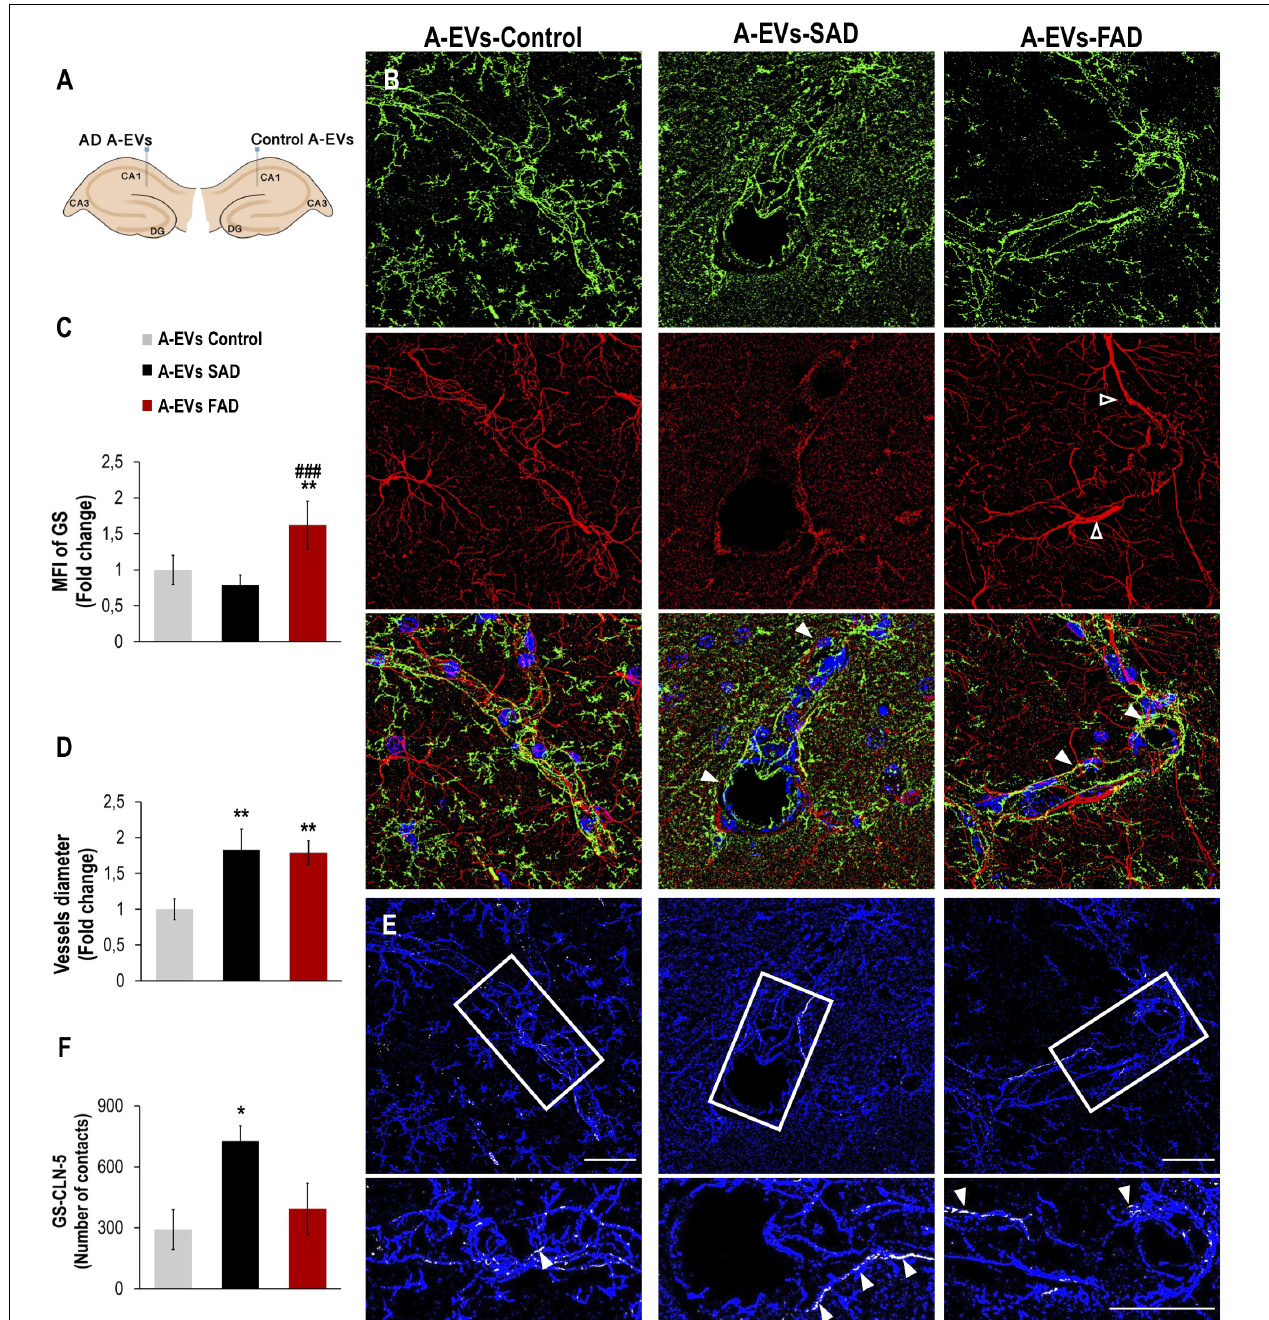
FIGURE 7 | Alzheimer’s disease EVs but not control EVs injection cause GS astrocyte alteration and higher vessel diameter in wild-type mouse brains. (A) A schema illustrating EVs from human A-EVs bilaterally injected to the hippocampus of C57BL6 mice at 10 months of age. (B) Representative of maximal Z-projection of Hoescht (blue), CLN-5 (green), GS (red) staining 48 h after intrahippocampal injection of CNT, FAD- and SAD A-EVs into aged C57BL6 mouse brain. Original magnification: × 60 (zoom 1.6). White arrowheads indicate regions where high vascular diameter, while empty arrowheads point to increased GS. (C) Quantification of the Z projected intensity of GS. ANOVA comparations of A-EVs FAD with ∗ A-EVs Control and # A-EVs SAD, levels of significance were set to * p < 0.05, ** p < 0.01, and ### p < 0.001. (D) Quantification of vessels diameter using of the CLN-5 Z projected images. ∗ Comparison with AEVs Control, levels of significance were set to ** p < 0.01. (E) Segmented images of GS endfeet (white) contacting CLN-5 vessel (blue). White arrowheads indicate regions where focal GS vascular coincides with CLN-5 staining. The insets are crop magnifications of double positive GFAP-CLN-5 areas (white). (F) Quantification of the endfeet volume of double positive GFAP-CLN-5. ∗ Comparison with A-EVs Control, levels of significance were set to * p < 0.05. Scale bar: (B,E) , 20 µ m. Data are presented as mean ± SEM from mice treated with CNT- ( n = 3), SAD- ( n = 3), and FAD- ( n = 3) A-EVs; independent experiments.